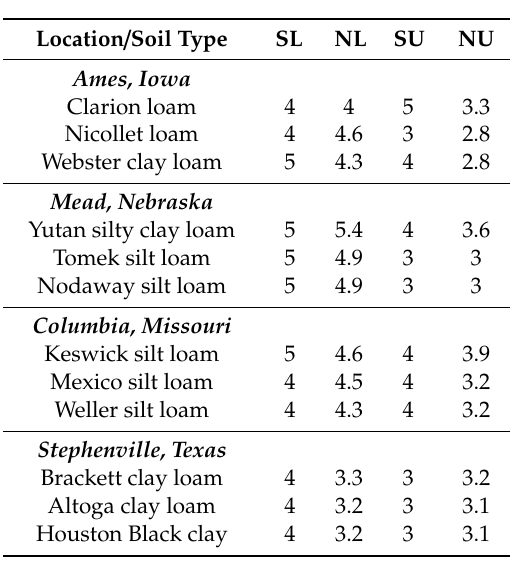
Table 2. Water use e ffi ciency (mg of biomass per g of water transpired) of four switchgrass simulated by ALMANAC [44]. Switchgrass types were southern lowland (SL), northern lowland (NL), southern upland (SU) and northern upland (NU) which were divided based on the latitude of switchgrass origins